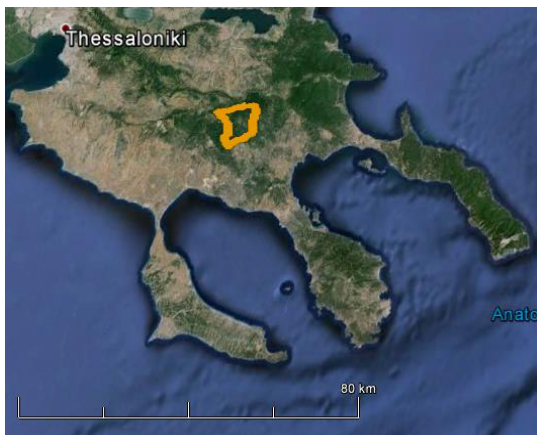
Figure 1. Geographical location of the University Forest Taxiarchis of Halkidiki is presented. © Google Earth, Copyright 2015.